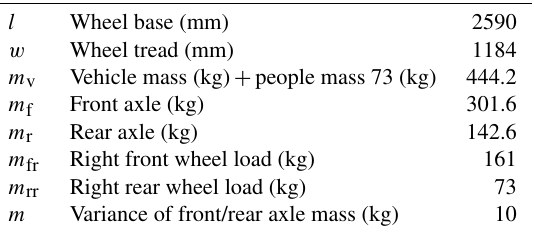
Table 2. Basic parameters of EV.